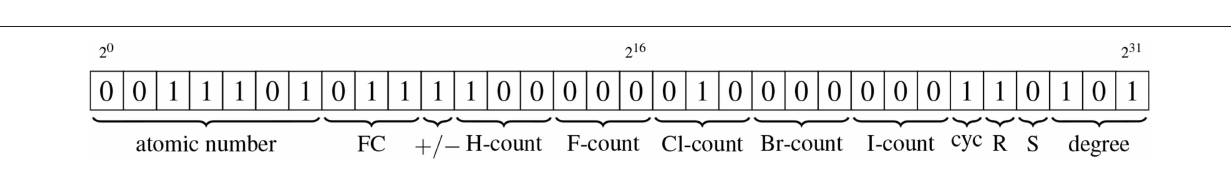
FIGURE 2 | Schematic illustrating how bit manipulation allows all information associated with a vertex to be stored using just 32 bits. The types of information are, from left to right: atomic number of the element associated with the vertex; magnitude of the formal charge of the atom associated with the vertex; sign of the formal charge; the counts of each of the five different elements that can be condensed into a vertex; whether the vertex is part of a cycle of size up to eight; the chirality (R/S) of the vertex; the degree of the vertex. All items are stored by converting the positive numeric values to binary format, other than the sign of the formal charge and the cycle and chirality indicators, for which the binary encodings are described in the